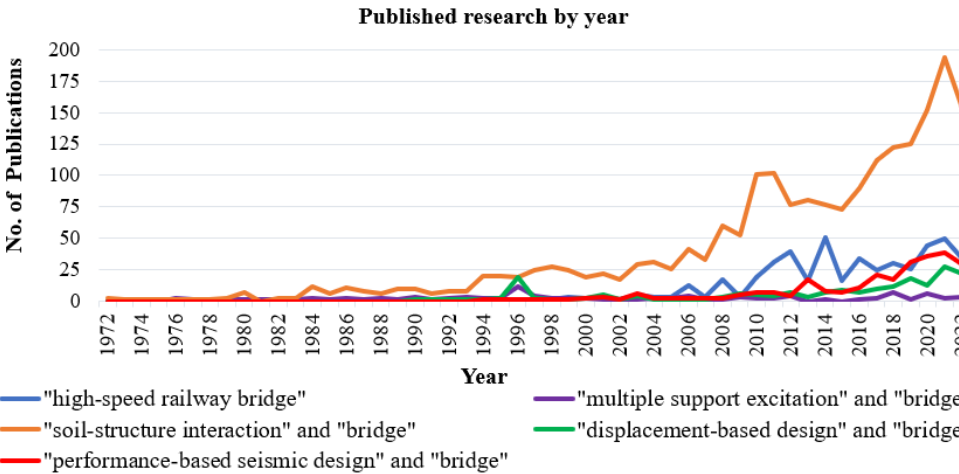
Figure 4. Graphical presentation of published research by year for bridge design.